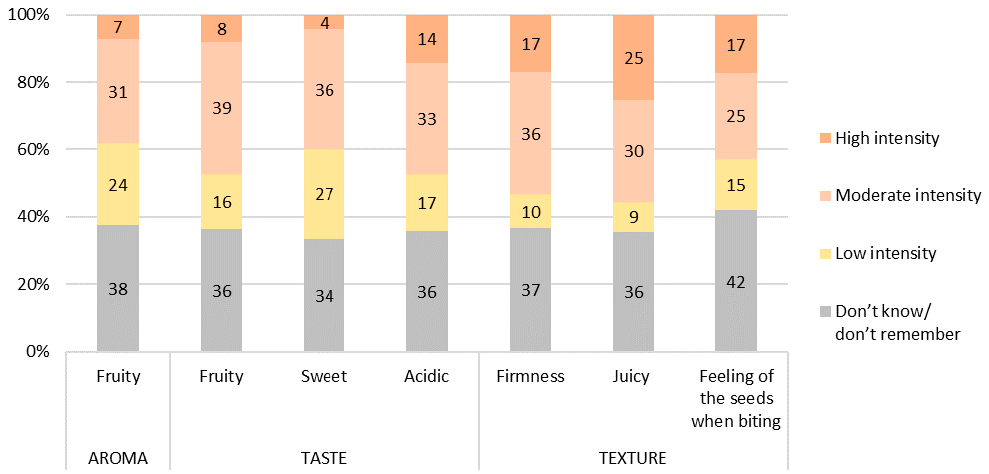
Figure 6. Opinion about the sensorial characteristics of the crowberries.